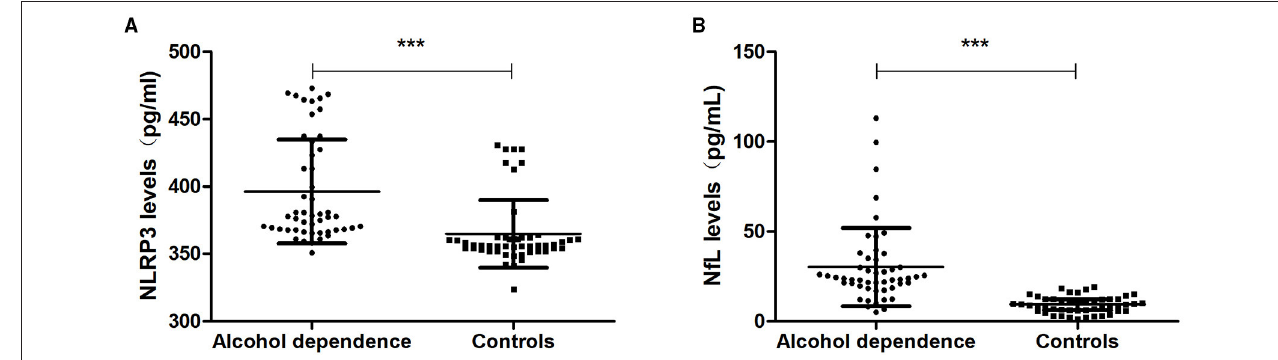
FIGURE 2 | NLRP3 and NfL levels in the alcohol dependence group and the controls. (A) The NLRP3 levels in the alcohol dependence group were higher than in the controls ( P < 0.001). (B) The NfL levels in the alcohol dependence group were higher than in the controls ( P < 0.001). *** P < 0.001.